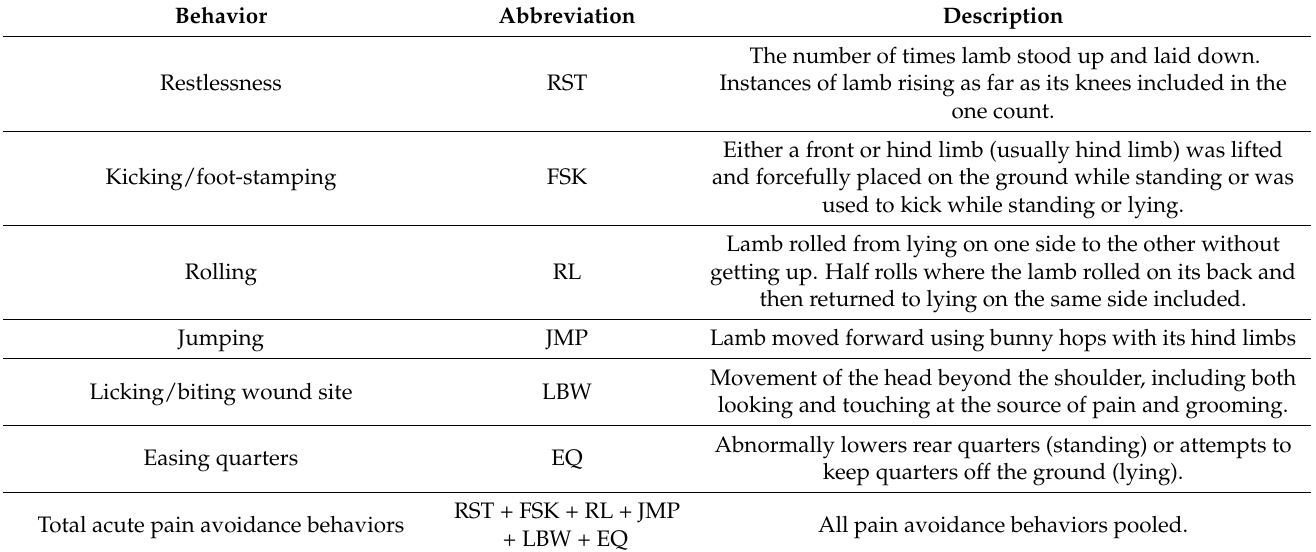
Table 2. Active pain avoidance behaviors were assessed during observation of recordings of animals described in Table 1 (adapted from Paull et al. 2012 [14]). In every 10-min block after treatment, the number of occasions each behavior was displayed lamb was